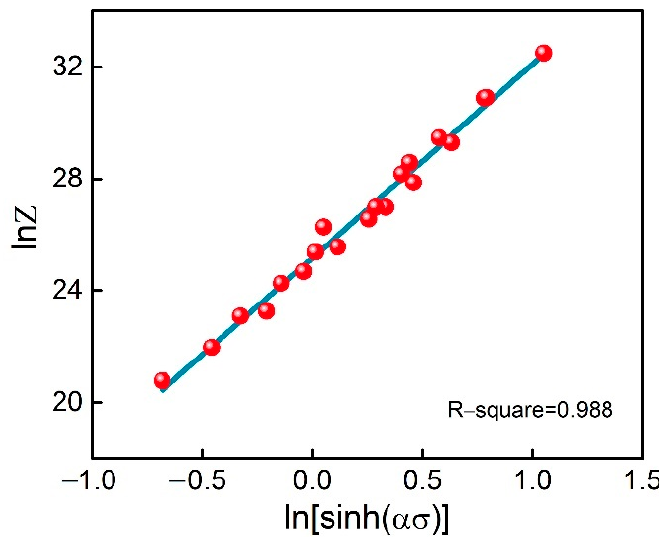
Figure 7. Relationship between ln Z and ln sin h (cid:4666) ασ (cid:4667) of ZnSnO 3 /Cu composites.